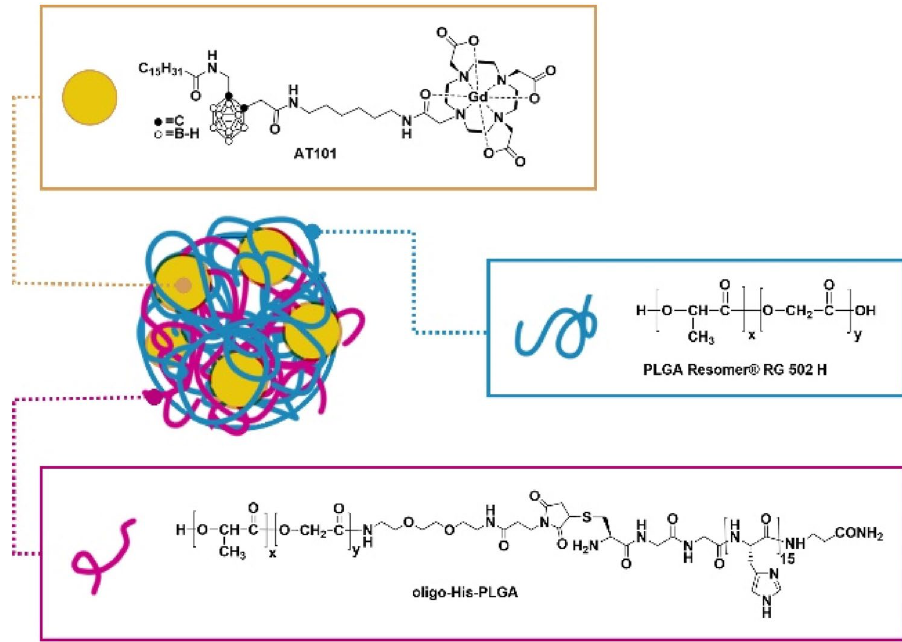
Scheme 1. Schematic representation of PLGA-His